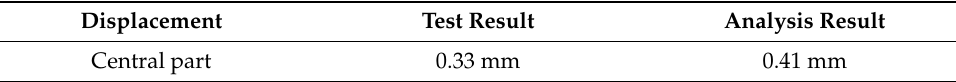
Table 5. Structural test results.